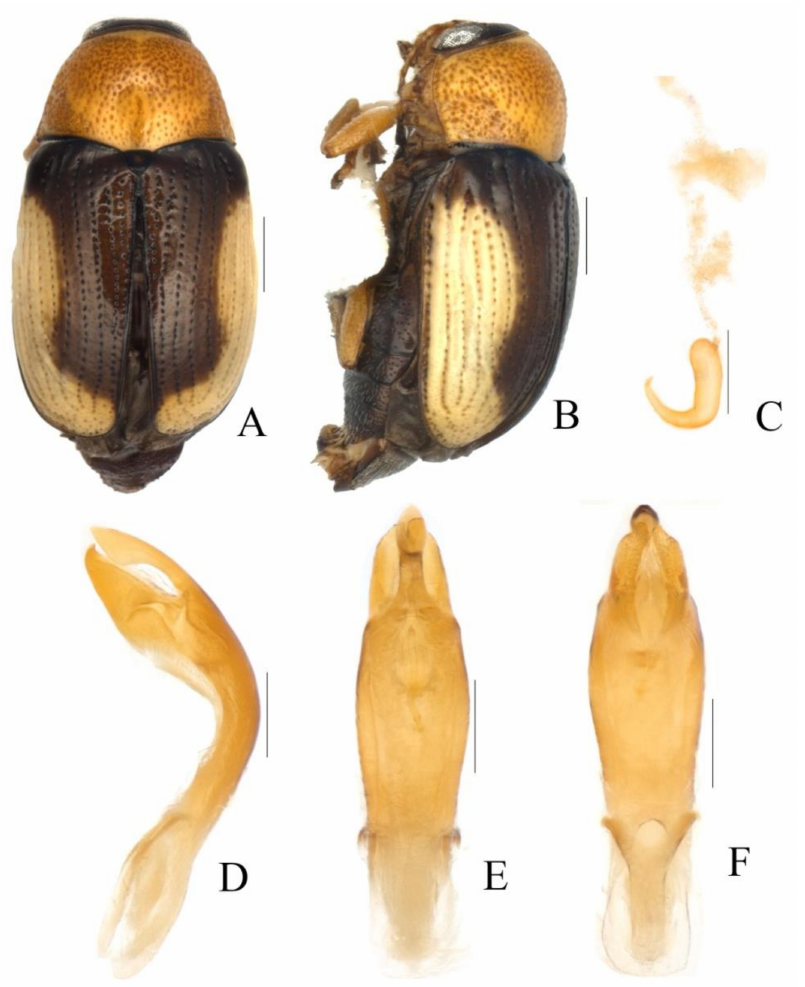
Figure 33. Cryptocephalus ( Burlinius ) shaowuanus Gressitt & Kimoto, 1961: ( A ) habitus; ( B ) lateral view of habitus; ( C ) spermatheca; ( D ) lateral view of aedeagus; ( E ) dorsal view of aedeagus; ( F ) ventral view of aedeagus (Scale bars: ( A , B ) = 0.5 mm, ( C – F ) = 0.2 mm) (( A , B , D – F ): male; ( C ): female; both from